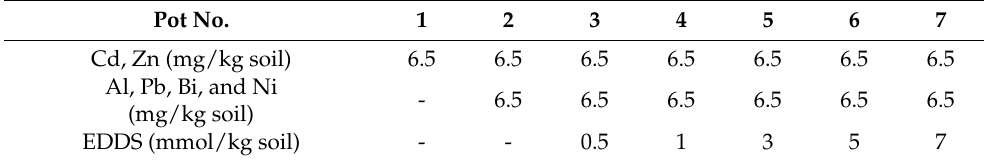
Table 2. Conditions of the pot experiments under the presence of other competitive metals. Pot No. Cd, Zn (mg/kg soil) Al, Pb, Bi, and Ni - (mg/kg soil) EDDS (mmol/kg soil) - -